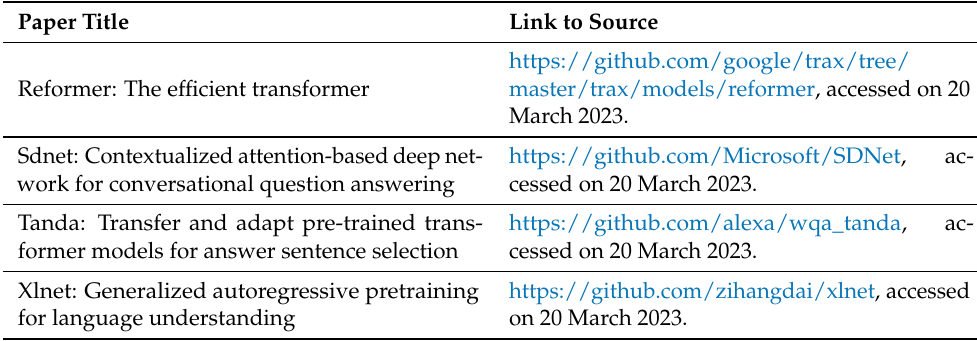
Table 2. Source code links for Question